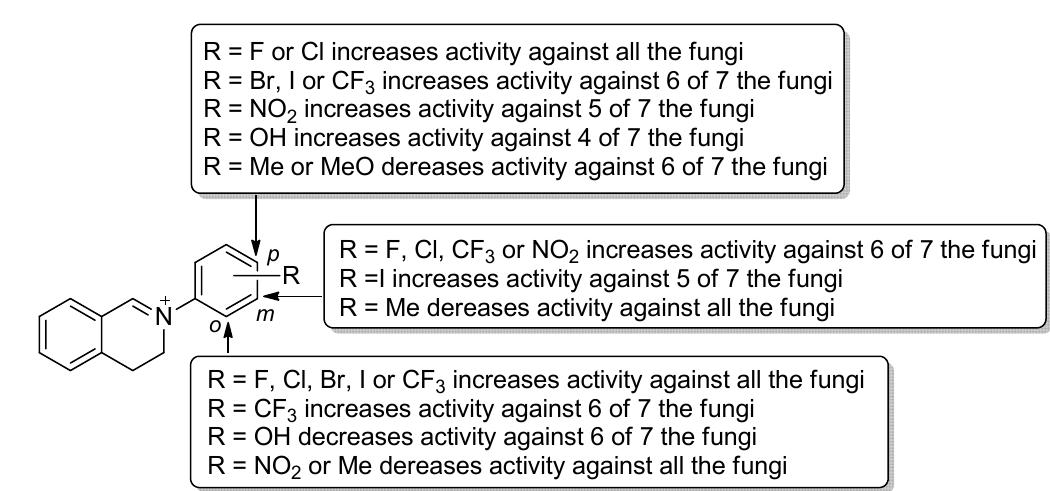
Figure 2. Structure-activity relationship of the compounds 1 – 24